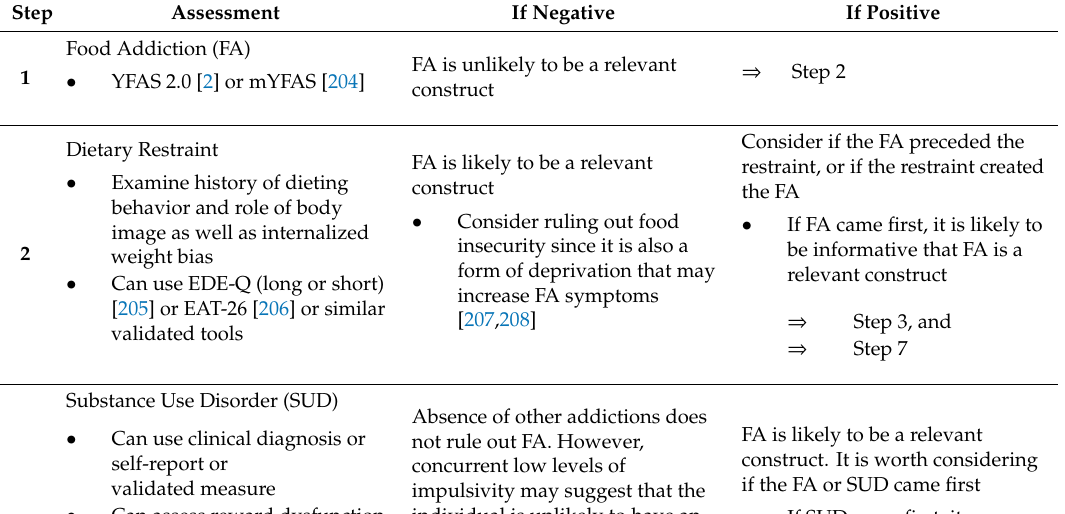
Table 1. Eight Step Process for Clinicians to Discern Food Addiction from Dietary Restraint in Order to Inform Inclusive vs. Exclusive Nutrition